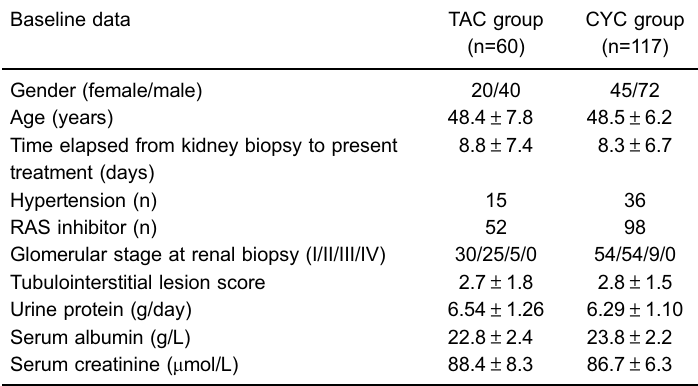
Table 1. Demographic, histological and laboratory characteristics of patients at baseline.